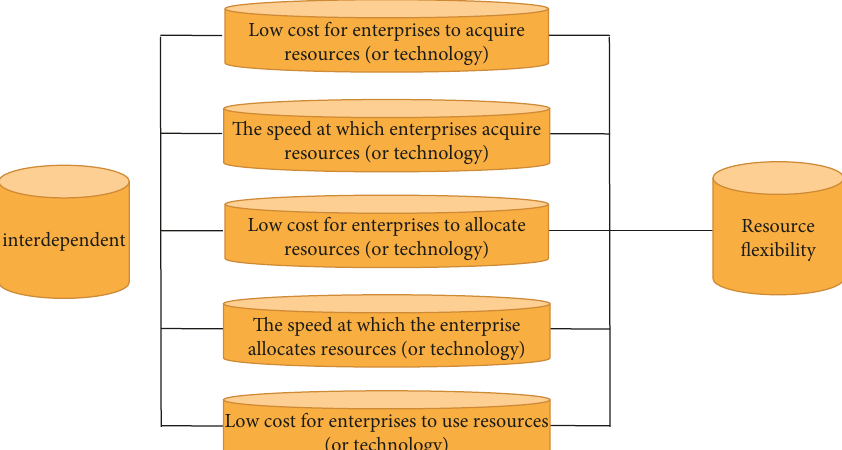
Figure 3: Formation of resource flexibility